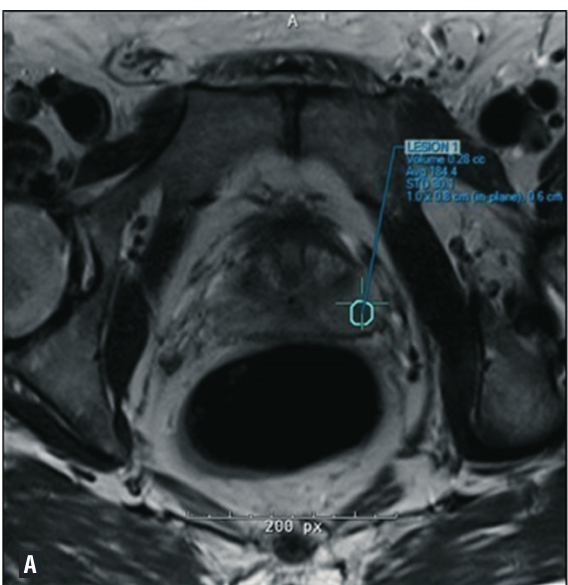
Figure 1 - volume hotspot on mpMRI of the